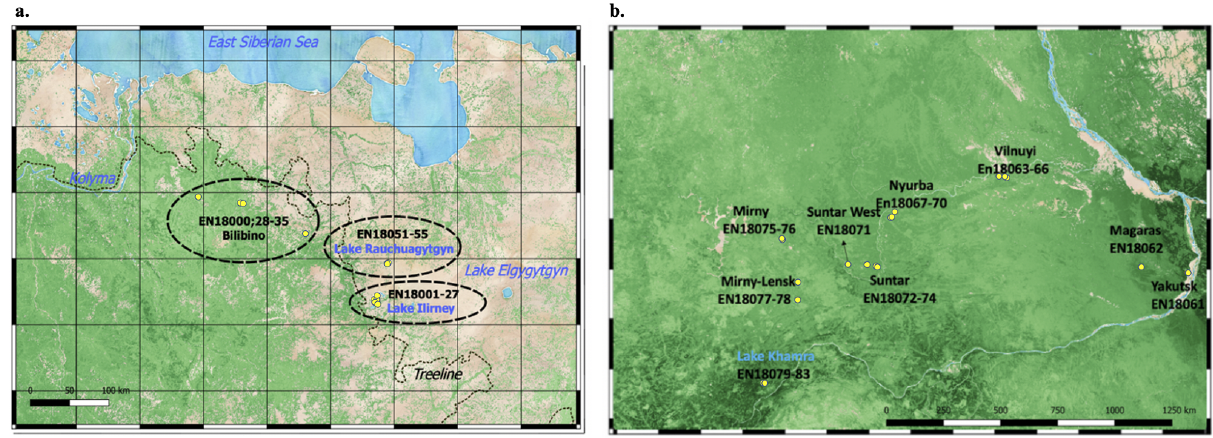
Figure 3. Subregions and plots (yellow points) for (a) Chukotka and (b) Central Yakutia: Bilibino (BI) (EN18000, 18028–35), Lake Ilir- ney (LI) (EN18001–27), and Rauchuagytgyn (RA) (EN18051–55), Yakutsk (YA) (EN18061), Magaras (MA) (EN18062), Vilnuyi (VI) (EN18063-66), Nyurba (NY) (EN18067–70), Suntar West (SW) (EN18071), Suntar (SU) (EN18072–74), Mirny (MI) (EN18075–76), Mirny- Lensk (ML) (EN18077–78) and Lake Khamra (LK) (EN18079–83). See also Table 1. The overview map (background © OpenStreetMap contributors 2022. Distributed under the Open Data Commons Open Database License (ODbL) v1.0.) shows forest coverage by green color- coded NASA forest height (Simard et al., 2011) and the northern treeline (CAVM Team, for Arctic Climate Impact Assessment,